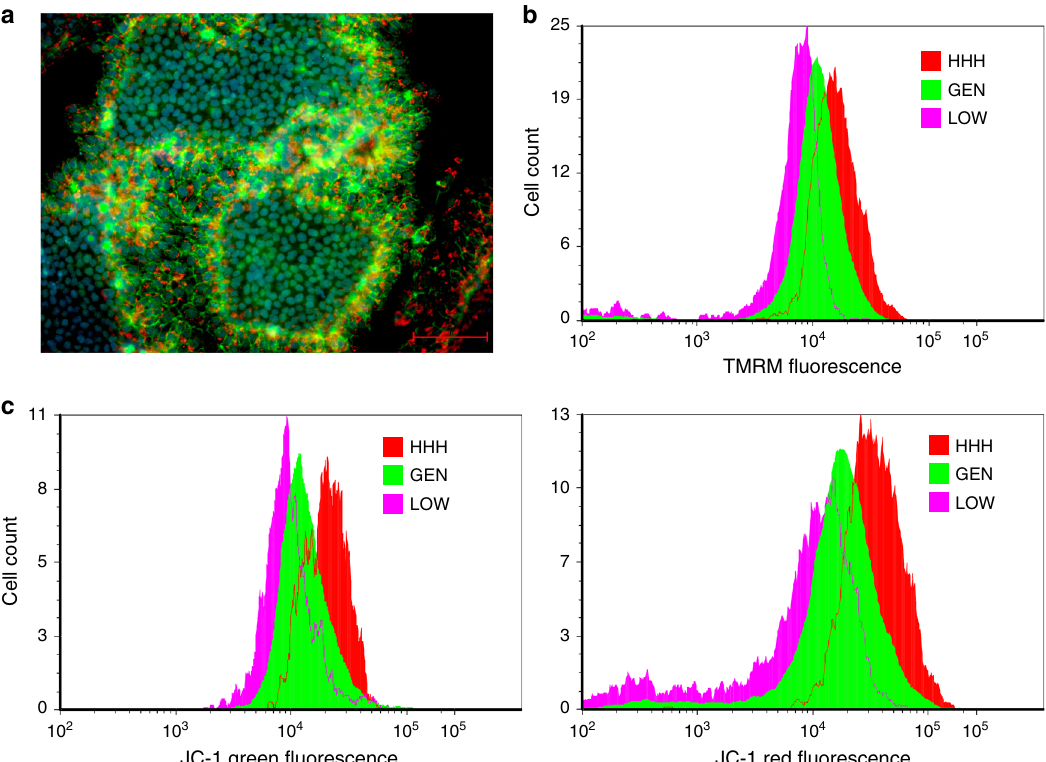
Fig. 4 Mitochondrial activity in subpopulations of hPSC. a Double label staining of live cells with TMRM and stem cell surface marker CD9. Cells at the edges of colonies stain most strongly with antibody and dye. Scale bar = 100 micron. b Flow cytometry analysis of TMRM staining in GCTM-2 high CD9 high EPCAM high (HHH), GCTM-2 low CD9 low (LOW), and unsorted (GEN) population. c Flow cytometry analysis of green (left panel) and red (right panel) JC-1 dye emission in GCTM-2 high CD9 high EPCAM high (HHH), GCTM-2 low CD9 low (LOW), and unsorted (GEN) population. GCTM-2 high CD9 high EPCAM high cells display highest ratio of green to red emission, indicative of high mitochondrial membrane potential. Results in a display representative outcomes from three